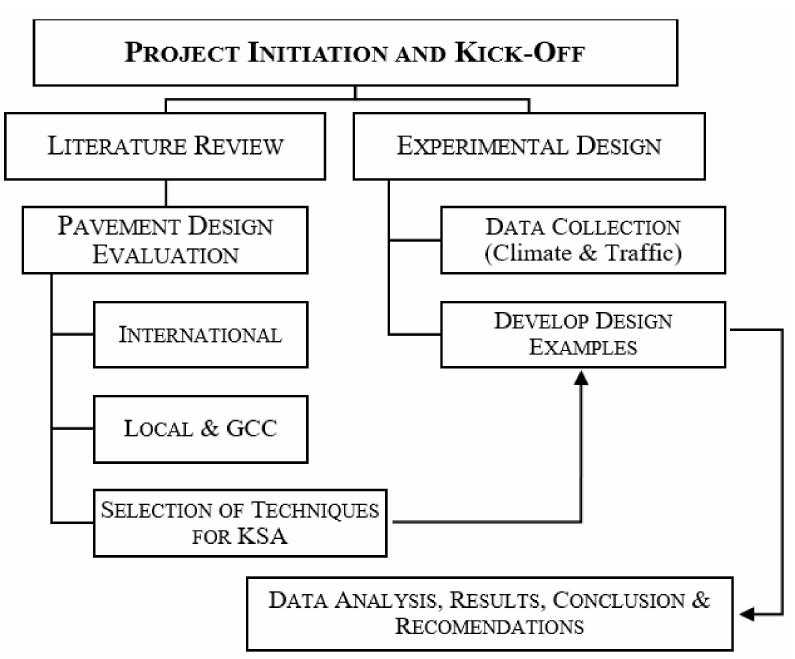
Figure 5. Flow-chart for the